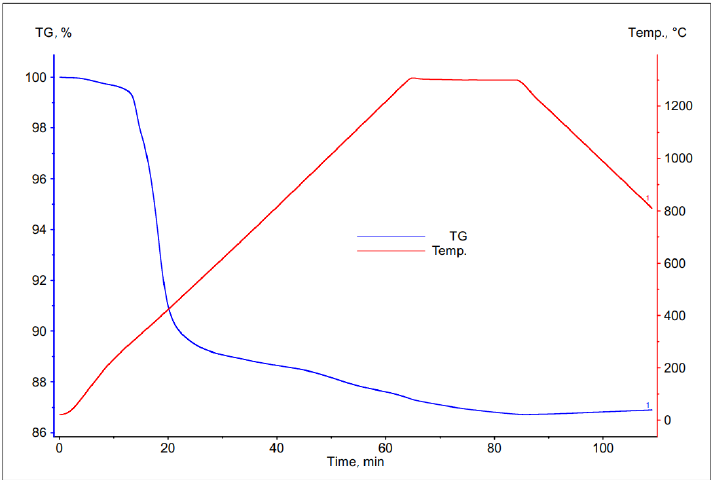
Figure 7. Change in mass of a sample with grain size 1.6 ÷ 3.15 mm during its heating.